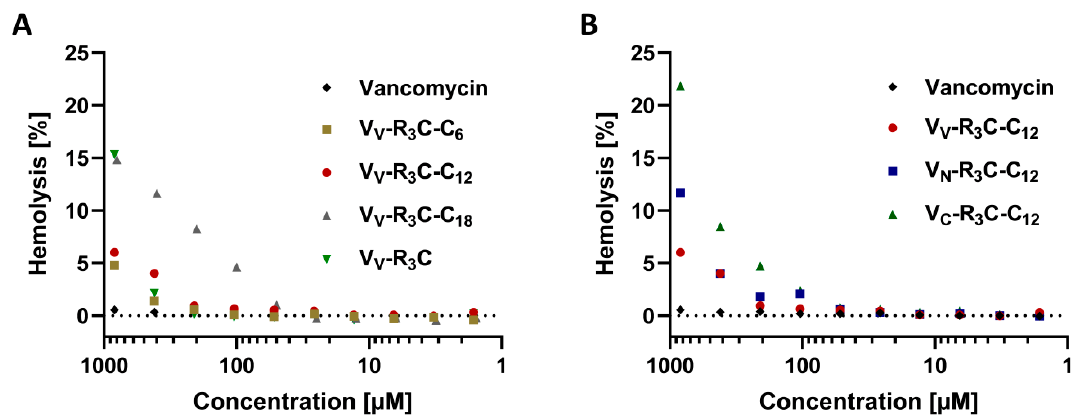
Figure 4. Hemolysis study of selected conjugates in comparison to vancomycin. The hemolytic activity of selected conjugates was investigated via a hemoglobin release assay. The concentrations applied ranged between 1 and 900 µ M. ( A ) V V -modified conjugates are compared with vancomycin. ( B ) The same modification at the three di ff erent modification sites is compared with vancomycin. All tested conjugates showed no relevant hemolytic e ff ect in target concentrations (below 2 µ M). Data (% lysis relative to complete lysis by TRITON ® X-100) are shown as the mean of three independent experiments tested in duplicate.